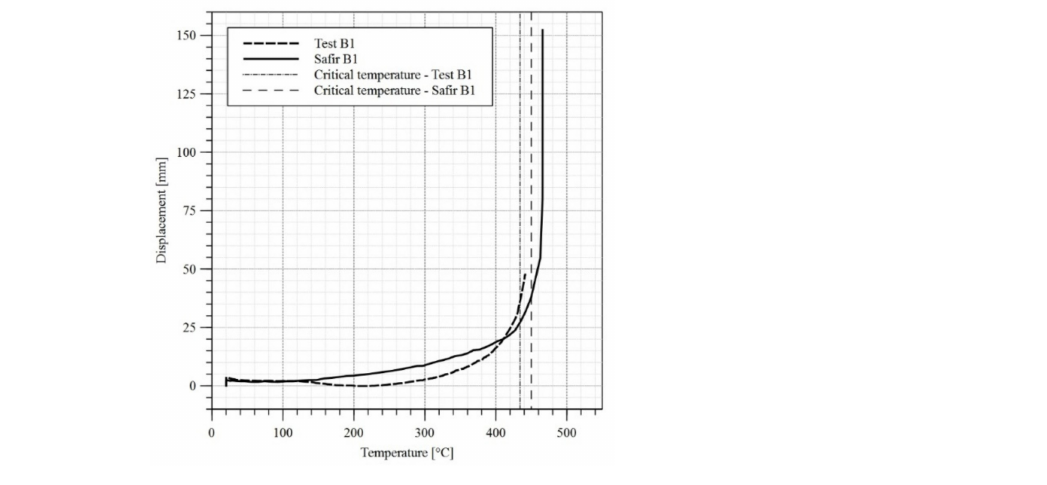
Figure 14. Horizontal displacement versus temperature diagram for the top flange of the girder—test B1.